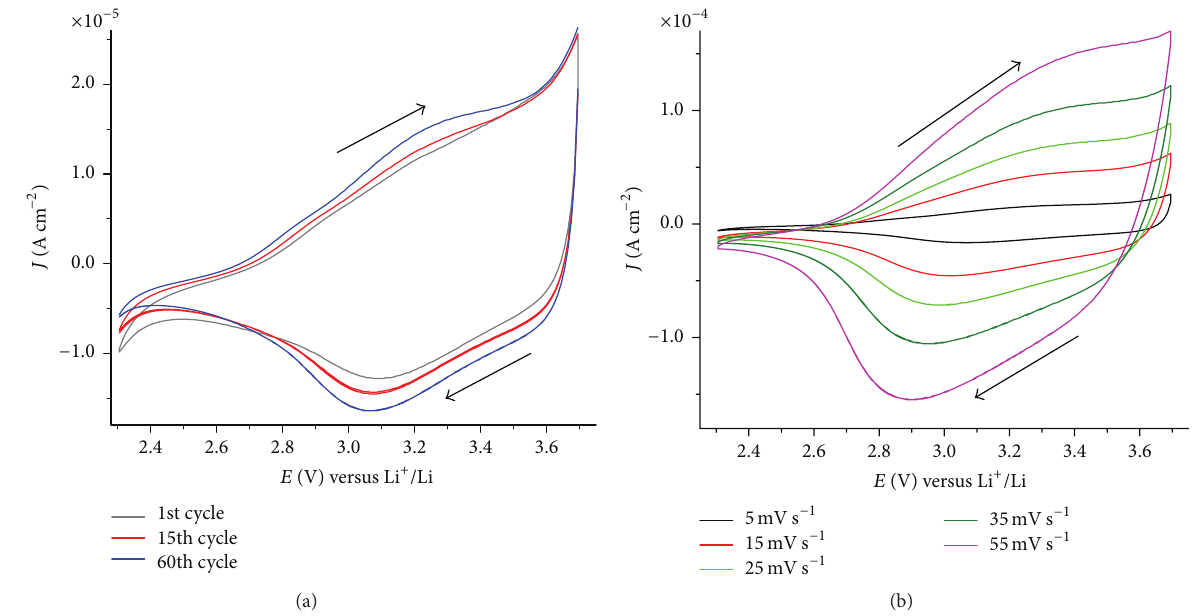
Figure 18: (a) Modification of the voltammogram of ERY-sensitized RDS NiO on ITO at 5 mVs −1 in dark conditions upon continuous x cycling (nickel oxide sample as in Figure 7). Electrolyte and cell configuration as in Figure 1. After about 60 cycles the voltammogram had a stabilized profile. Arrows indicate the verse of potential scan. (b) Cyclic voltammograms of ERY-sensitized RDS NiO spray-deposited onto ITO after stabilization of the voltammogram (a). All voltammograms have been recorded in dark conditions. Scan rates have been varied between 5 and 55 mVs −1 . ERY-sensitized RDS NiO sample was initially cycled 80 times at 5 mVs −1 (a). Counter electrode: Li; reference redox couple: Li + /Li. Electrolyte composition as in Figure 1. Arrows indicate the verse of potential